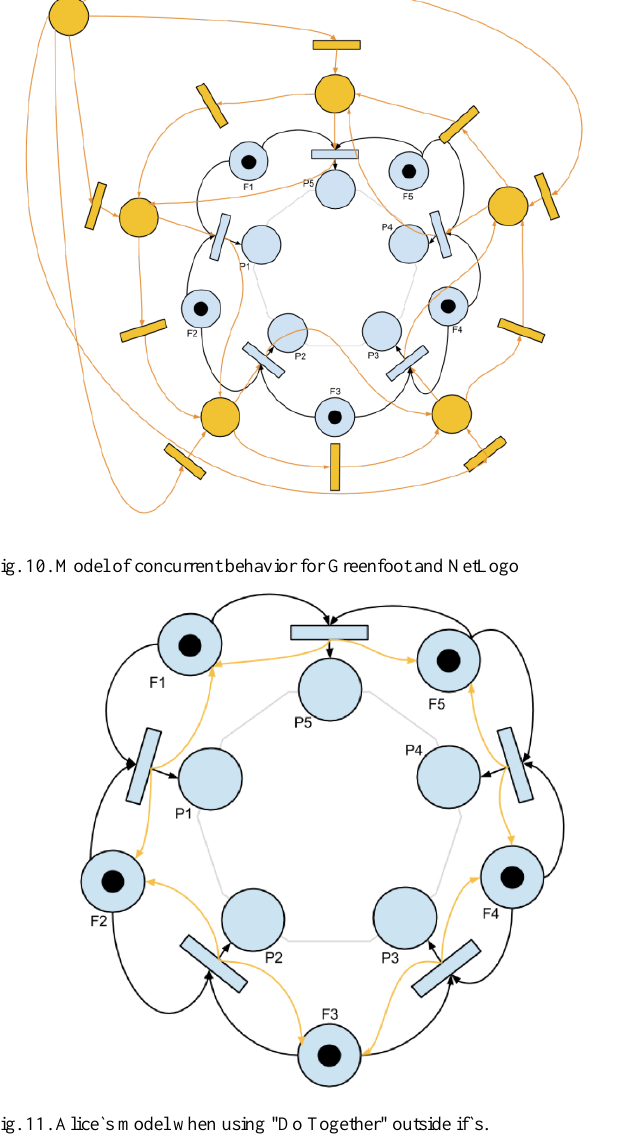
Fig. 11. Alice`s model when using "Do Together" outside